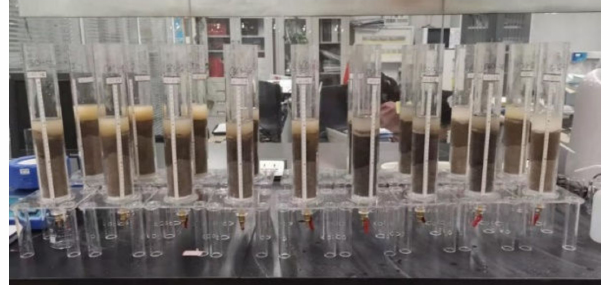
Figure 9. Soil column